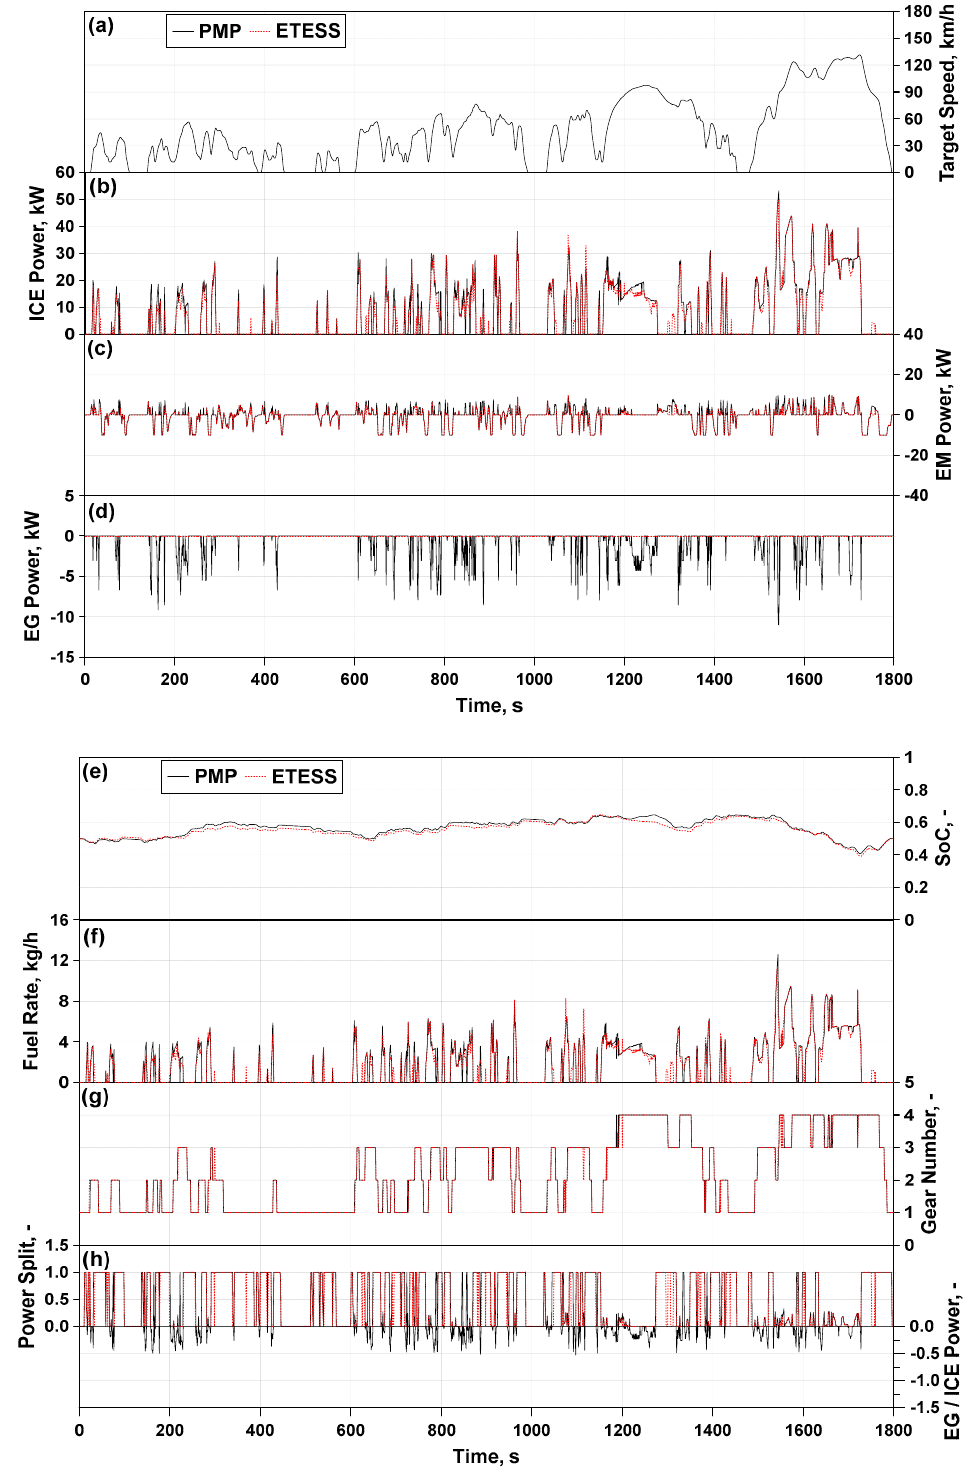
Figure 9. PMP-ETESS comparisons of ICE power ( b ), EM power ( c ), EG power ( d ), SoC ( e ), fuel rate ( f ), GB 1 number ( g ) and vehicle mode ( h ) along the WLTC (vehicle speed—( a ))—case #4. For the ETESS, because of the impossibility of an EG battery charging, pure ICE driv- ing is very often chosen (Figure 9b). On the contrary, for the PMP, in most parts of the driving cycle with positive power demand, the EG battery charging is activated (Figure 9d). This allows employing the EM more frequently compared to ETESS (Figure 9c). As